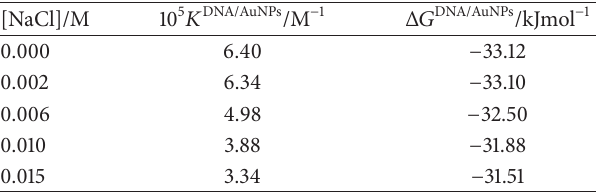
Table 1: Binding constants ( 𝐾 DNA/AuNPs ) and the free energy of binding ( Δ𝐺 DNA/AuNPs ) corresponding to DNA/AuNPs interaction at different NaCl